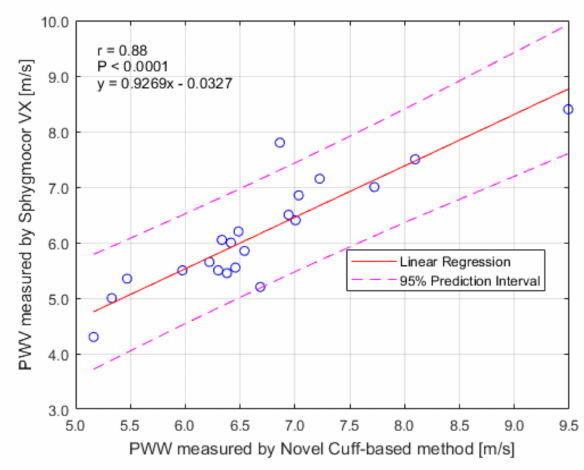
Figure 5. Linear